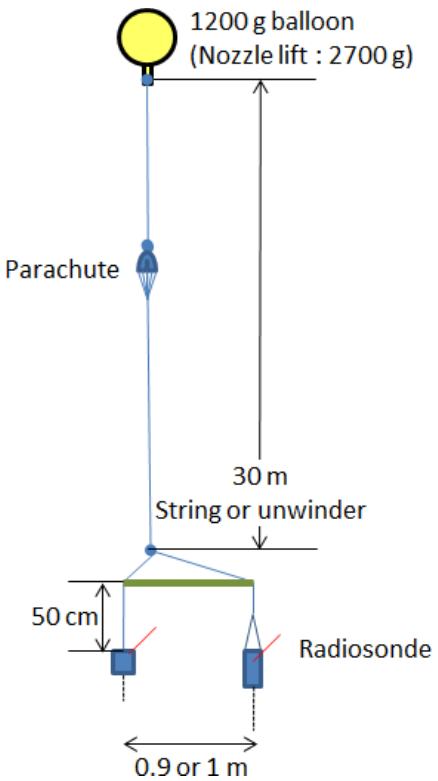
Figure 6. Flight